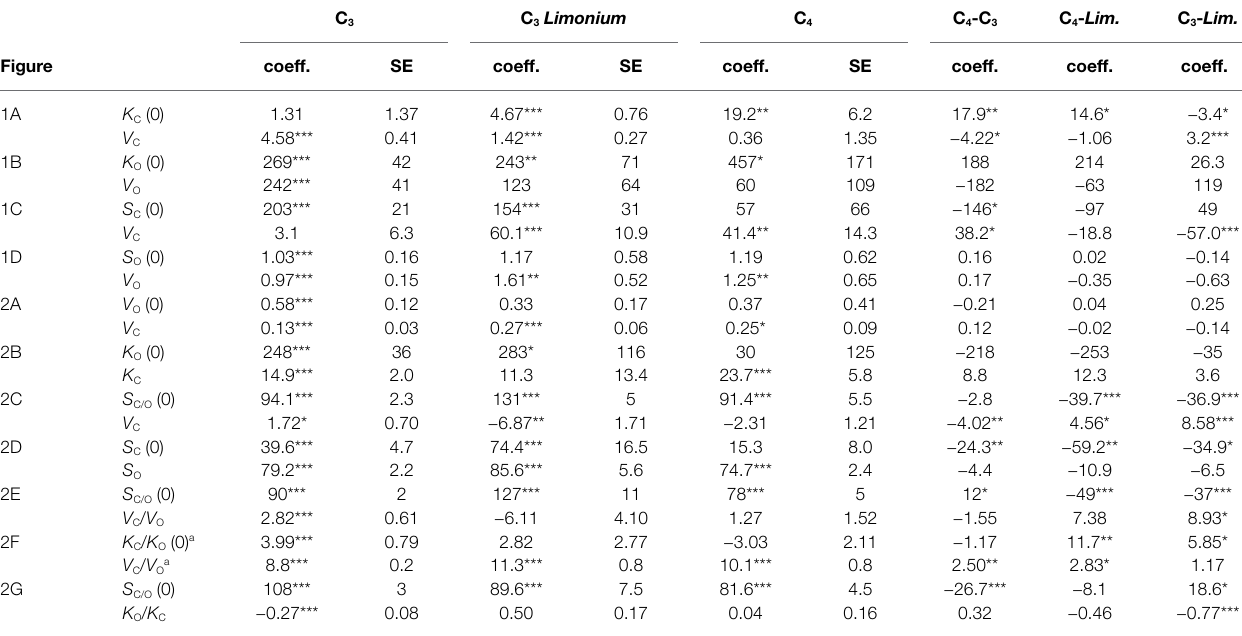
TABLE 2 | Results of linear regression analysis for C 3 (excluding Limonium ), C 3 Limonium , and C 4 plants.